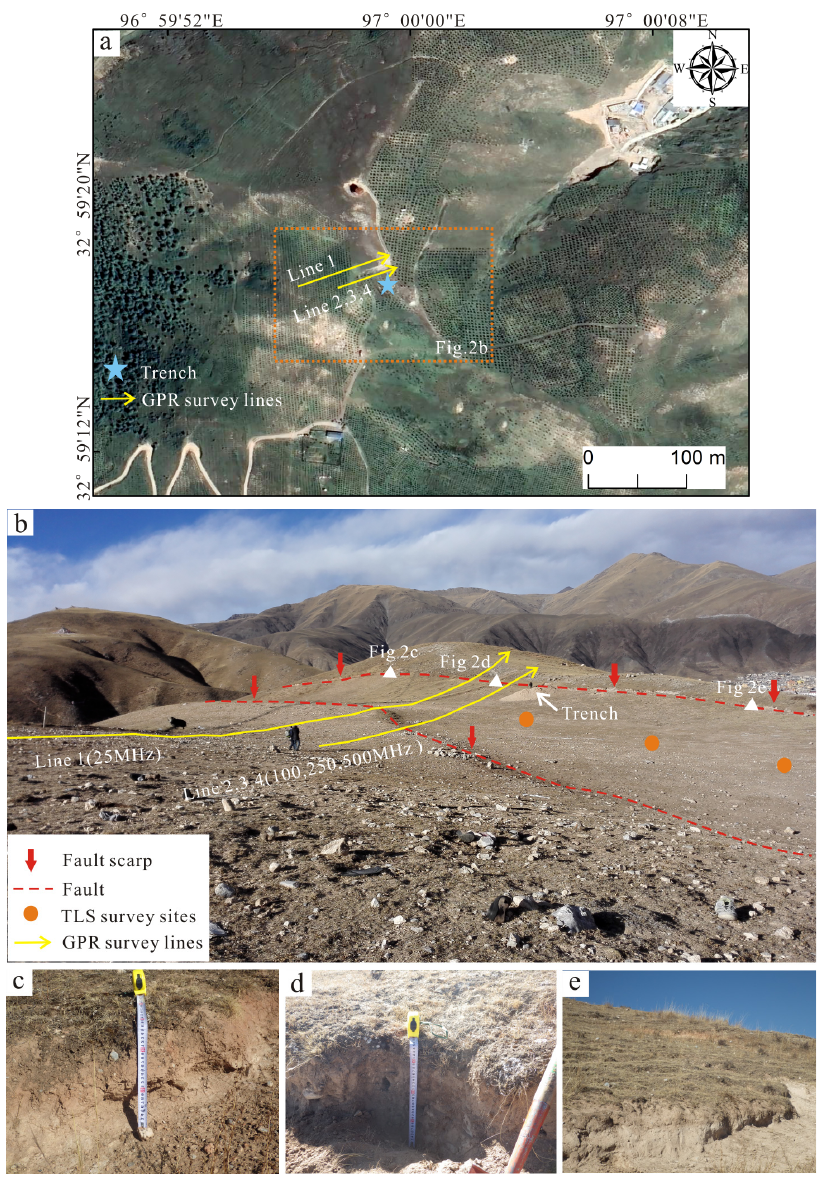
Figure 2. Geomorphic map of the study site. ( a ) Google Earth image. Yellow lines represent 2D GPR survey lines: Line 1 is the 25 MHz GPR survey line and Lines 2, 3, 4 are the 100 MHz, 250 MHz and 500 MHz GPR measuring lines. ( b ) Field photos of the study site. Red arrows represent fault scarps, red do tt ed lines show fault traces and orange circles are TLS scanning positions. White triangles represent fault scarps in Figures 2c–e. ( c – e ).